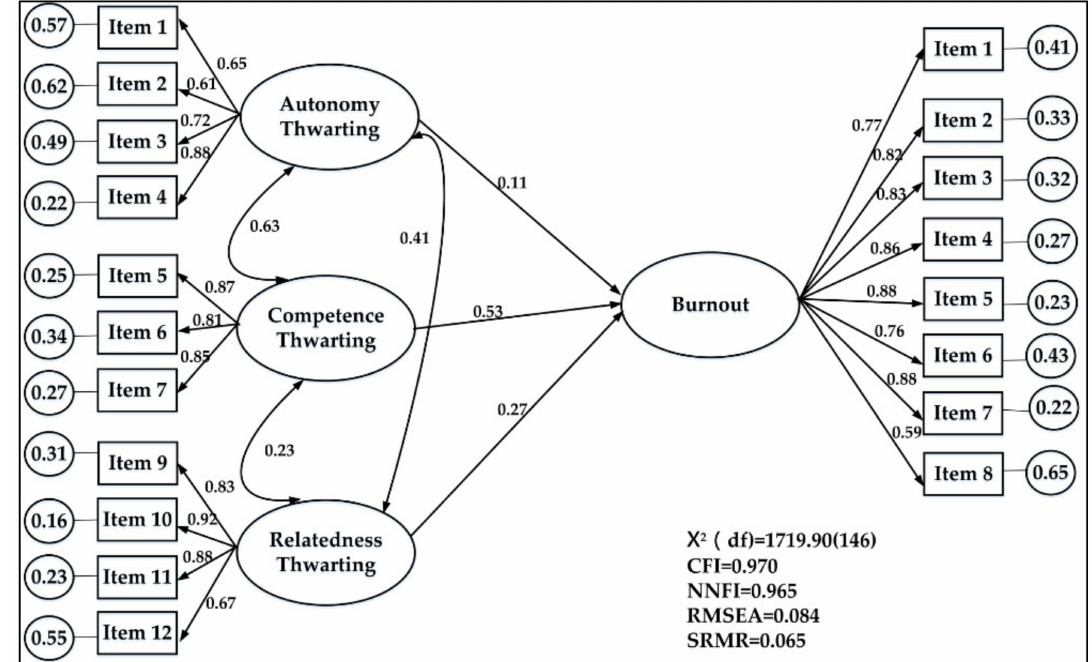
Figure 1. Structural equation model of the Chinese Psychological Need Thwarting of Teachers (CPNTT) on teacher